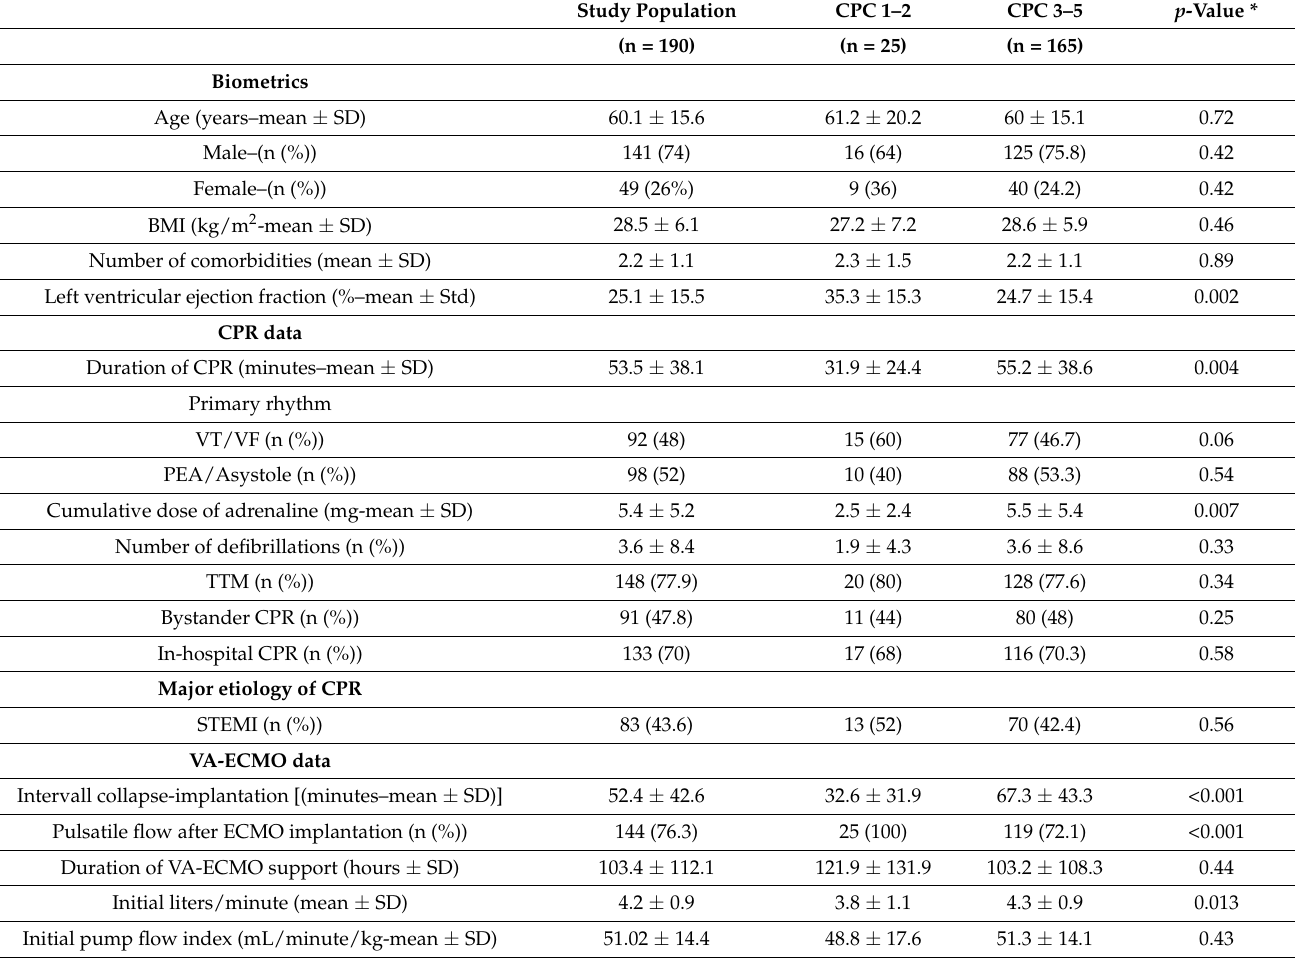
Table 1. Baseline characteristics, resuscitation-associated parameters, and clinical/technical VA- ECMO data of the total study population and the two outcome groups (CPC 1–2 and CPC